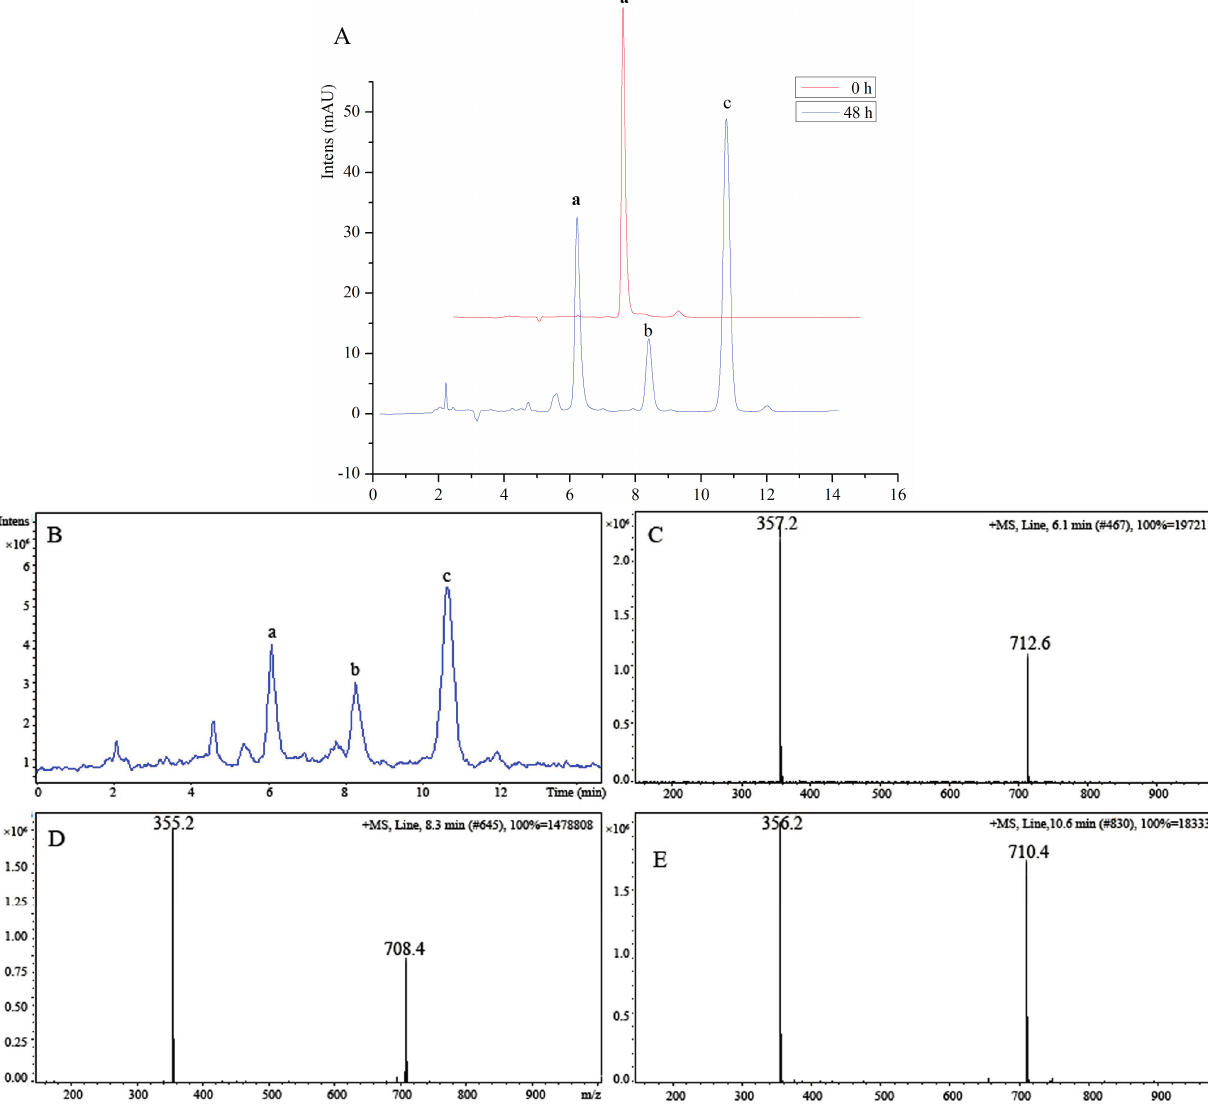
Figure 2. Evaluation of the instability of 8-amino-isocorydine ( 8 ) using the HPLC-UV-MS